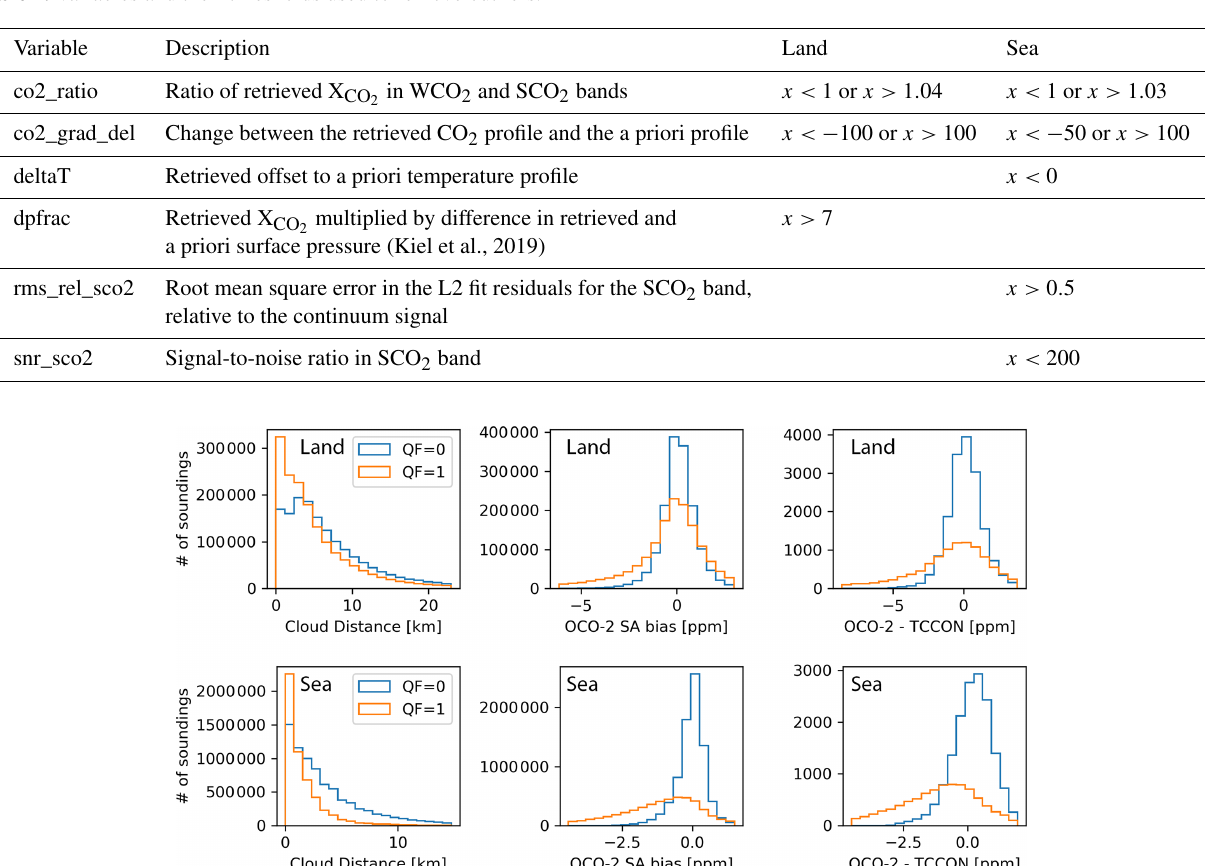
Table 1. Variables and their thresholds used to remove outliers.